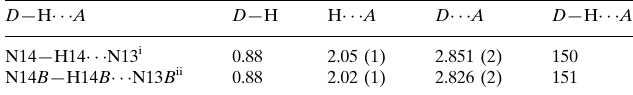
Hydrogen-bond geometry (A˚ , (cid:1)